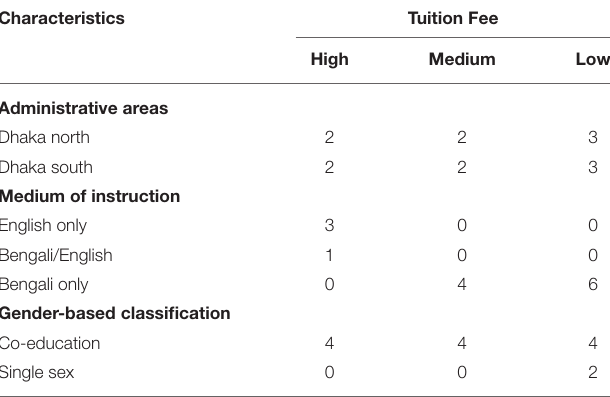
TABLE 1 | Characteristics of